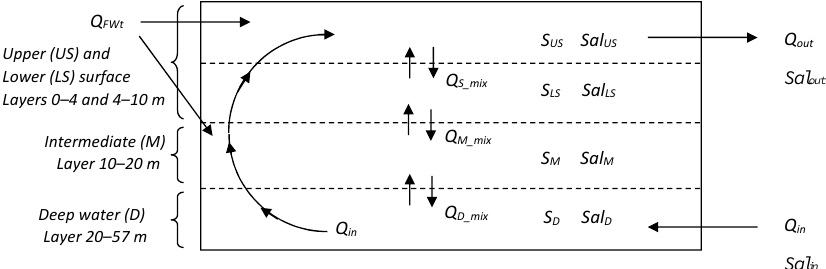
Figure 2. Schematic illustration of the box model for water flows ( Q ), salt amounts ( S ), and salinities (Sal). Salt is transported from the middle archipelago through the Oxdjupet strait ( Q in Sal in according to Eq. 2) and forms the inner archipelago deep water, with salt content S D . Upwelling water (equivalent to Q in ) transports salt to the above layers and mixing ( Q D the